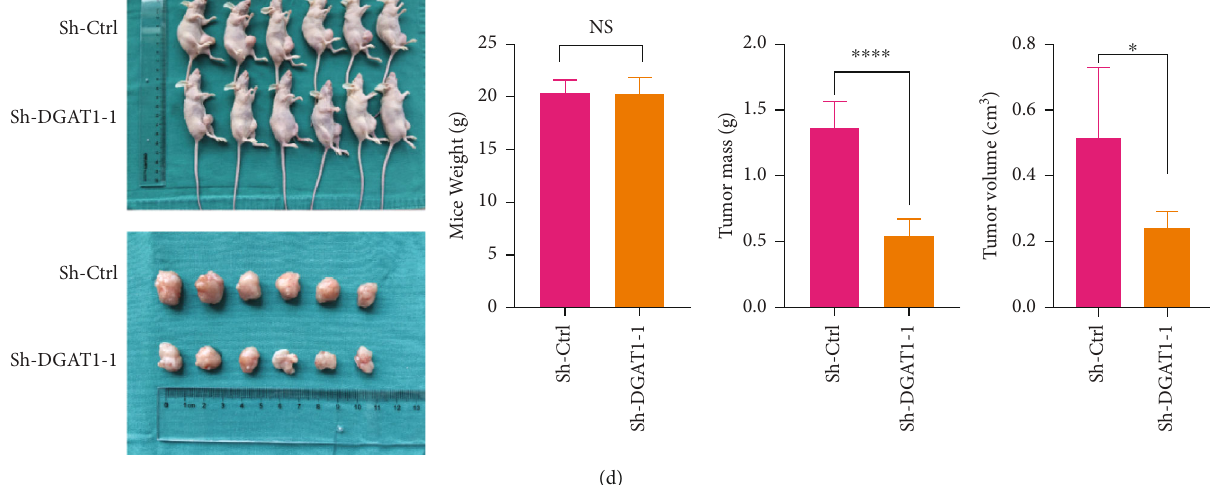
Figure 3: DGAT1 promotes proliferation, colonization, and metastasis of ovarian cancer. (a) CCK-8 cell proliferation assay was carried out using OVCAR-5 and PEO4 cells with sh-Ctrl, sh-DGAT1. (b) Colony formation assay was performed using OVCAR-5 and PEO4 cells with sh-Ctrl, sh-DGAT1. (c) Transwell migration assay was conducted using OVCAR-5 and PEO4 cells with sh-Ctrl, sh-DGAT1. (d) Tumor model is established using sh-Ctrl, sh-DGAT1 OVCAR-5 transfected cells ( p ≥ : 05 =ns, p ≤ : 05 = ∗ , p ≤ : 01 = ∗∗ , p ≤ : 001 = ∗∗∗ , p ≤ : 0001 = ∗∗∗∗